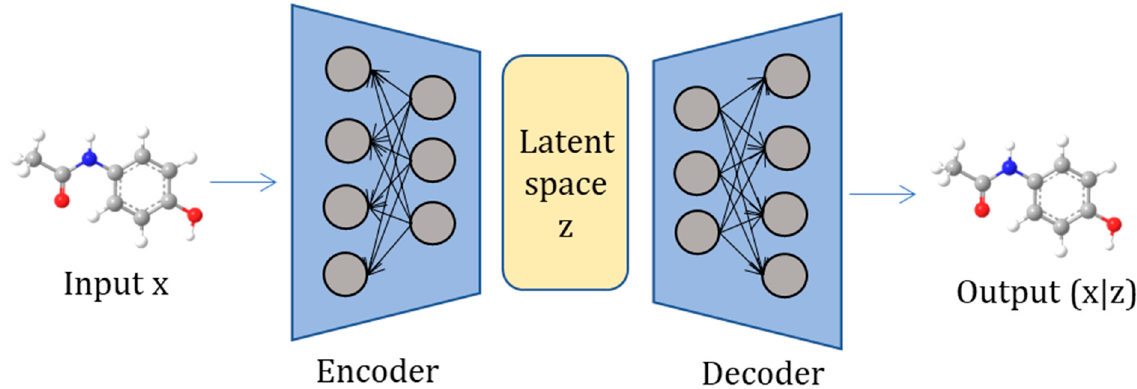
Figure 3. An autoencoder consists of an encoder functionality, which translates an input into a latent space, and a decoder, which translates the internal latent space back to the original input space. The goal of the autoencoder is to compute a reconstruction x’ with minimal error compared to the original input x.